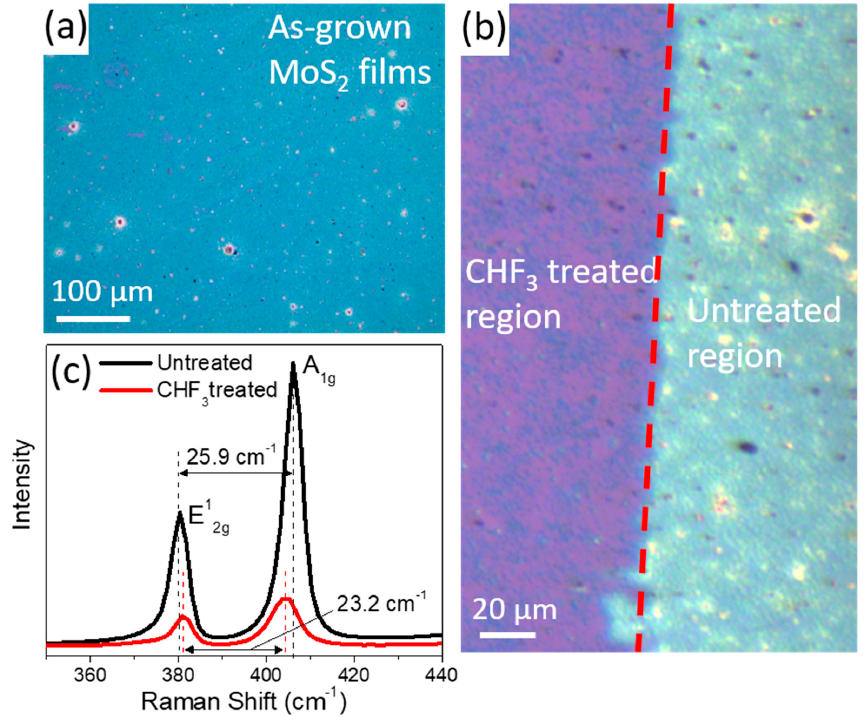
Figure 1. ( a ) Optical micrograph (OM) image of the as-grown MoS 2 films on the SiO 2 /Si substrate. ( b ) OM image of the selective-area MoS 2 films with and without CHF 3 plasma treatment. ( c ) Raman spectra taken of the untreated and CHF 3 -treated regions.